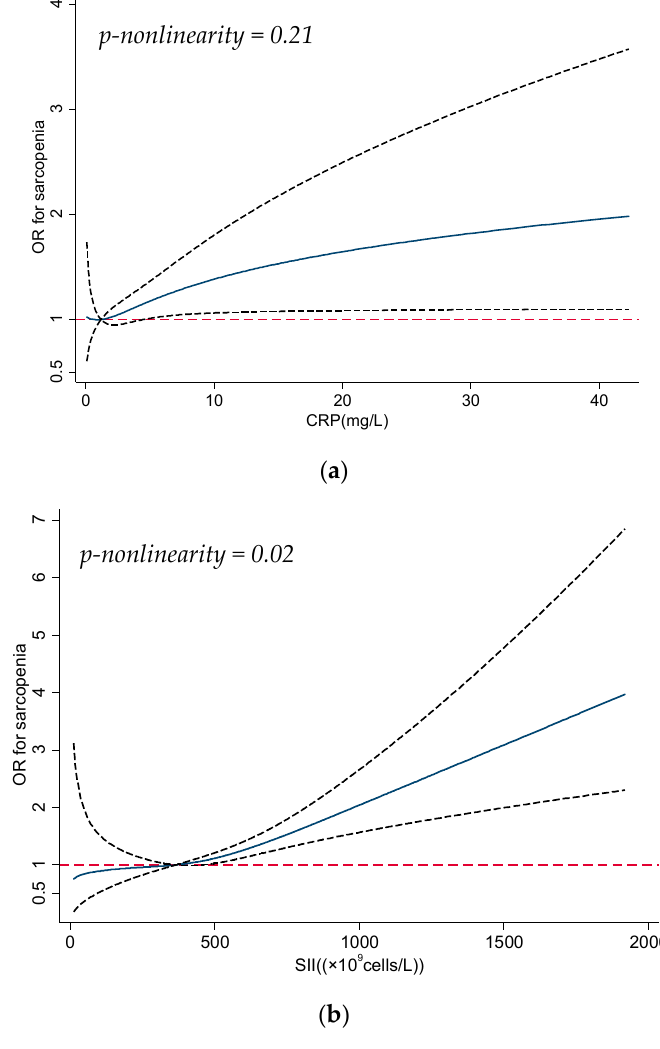
Figure 1. ( a ) Dose–response curve for association between CRP and sarcopenia; the solid line shows the odds ratios (ORs), and the dotted line represents the 95% confidence intervals. CRP = 1.2 mg/L was used as the reference in the curve. Abbreviations—CRP: C-reactive protein. ( b ) Dose–response curve for association between SII and sarcopenia; the solid line shows the odds ratios (ORs), and the dotted line represents the 95% confidence intervals. SII = 365.7 × 10 9 cells/L was used as the reference in the curve. Abbreviations—SII: systemic immune-inflammation index. Table 3. Subgroup analysis for association between inflammatory biomarkers and sarcopenia, NHANES 1999–2006 ( n = 2483).